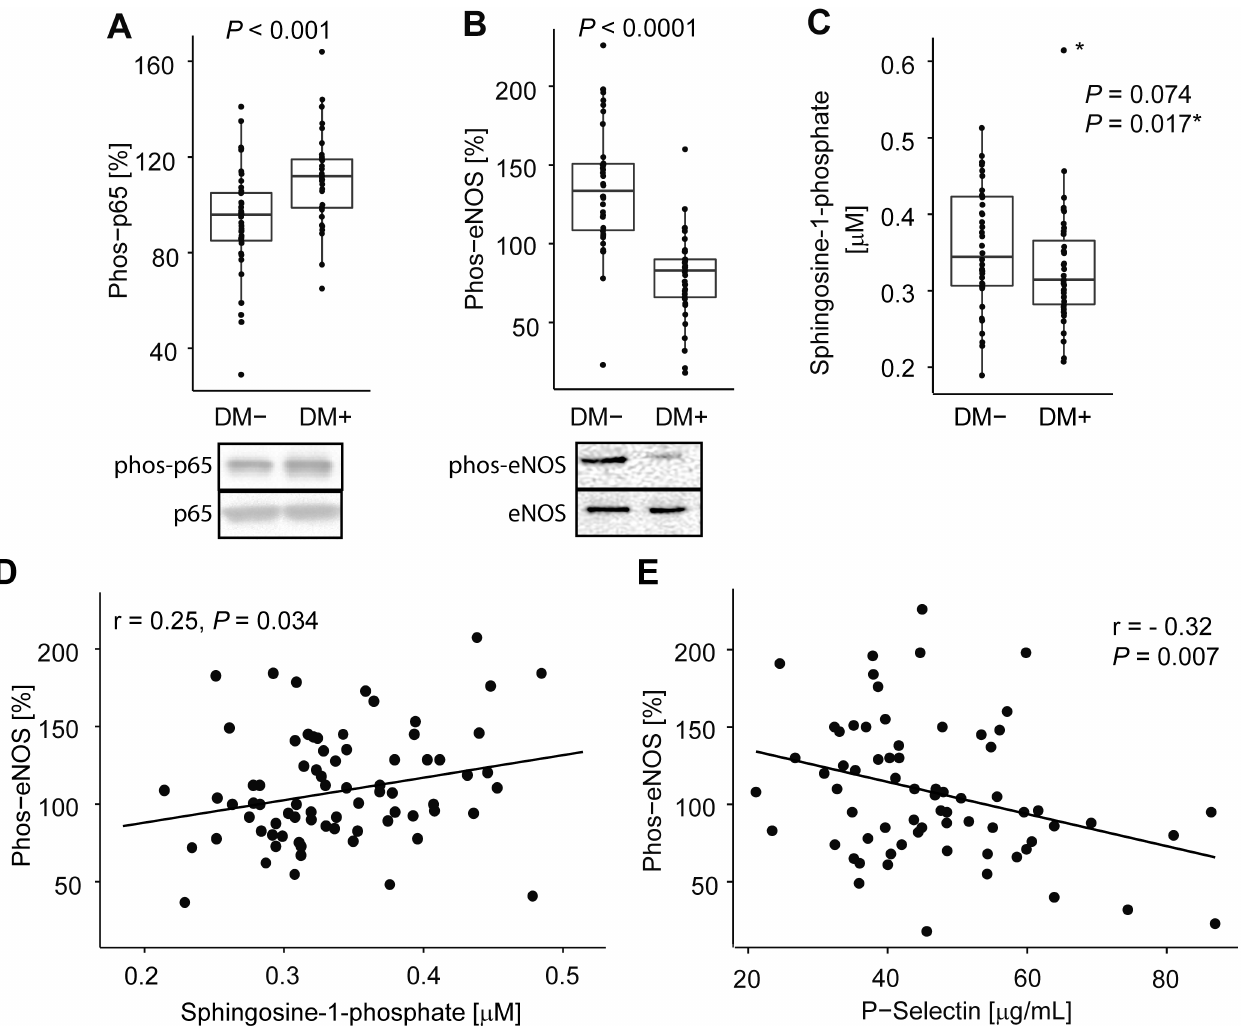
Fig 1. Protective effects of HDL on endothelial cells are impaired in diabetes, correlate with S1P and negatively associate with in vivo measure of endothelial dysfunction. (A) The ability of HDL to suppress NF κ B activation was measured as phosphorylation of p65 in HMEC after 16 h incubation with HDL (50 μ g/mL) followed by 4 h stimulation with TNF α (n = 41 per group). (B) The ability of HDL to stimulate eNOS Ser1179 phosphorylation was measured in BAEC after 30 min incubation with HDL (50 μ g/mL) (n = 38 non-diabetic, n = 41 diabetic subjects). (Data is expressed relative to cells not treated with HDL). (C) Sphigosine-1-phosphate concentration measured by LC-MS is reduced in patients with diabetes and (D) correlates positively with HDL ability to stimulate eNOS phosphorylation (n = 40 non-diabetic, n = 39 diabetic subjects; (cid:3) excluded outlier and P -value after exclusion). (E) The ability of HDL to stimulate eNOS is inversely correlated negatively with level of P-selectin in plasma, an in vivo measure of endothelial dysfunction (Pearson correlation coefficient; n = 81 after an outlier exclusion).